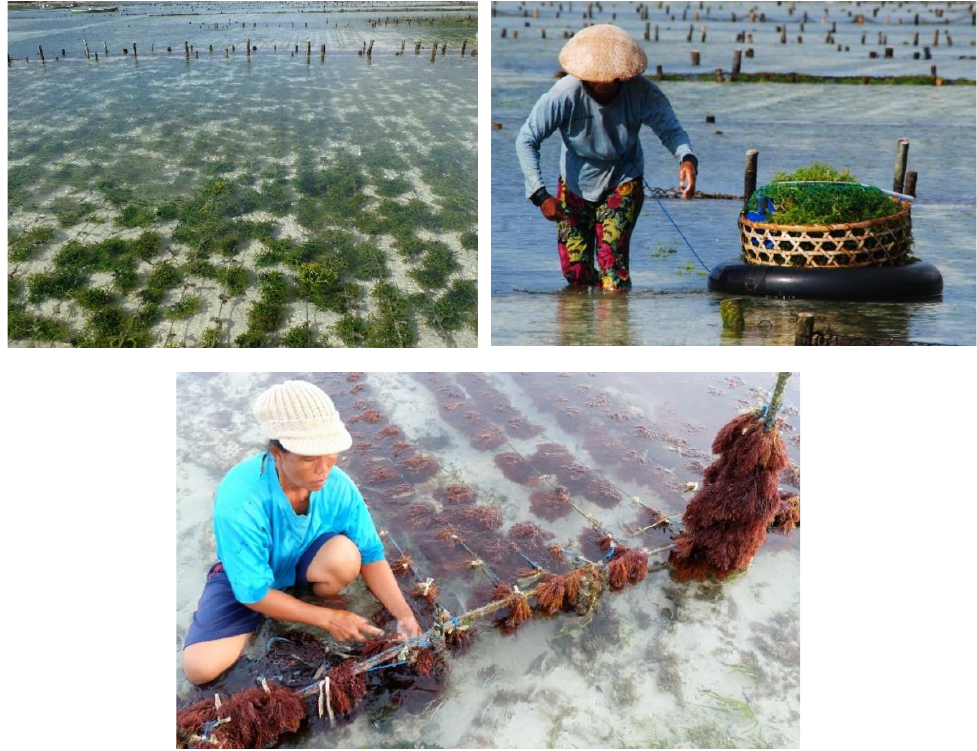
Figure 10. Activities of seaweed farming ( Eucheuma spp. and Halymenia spp.) in Bali,